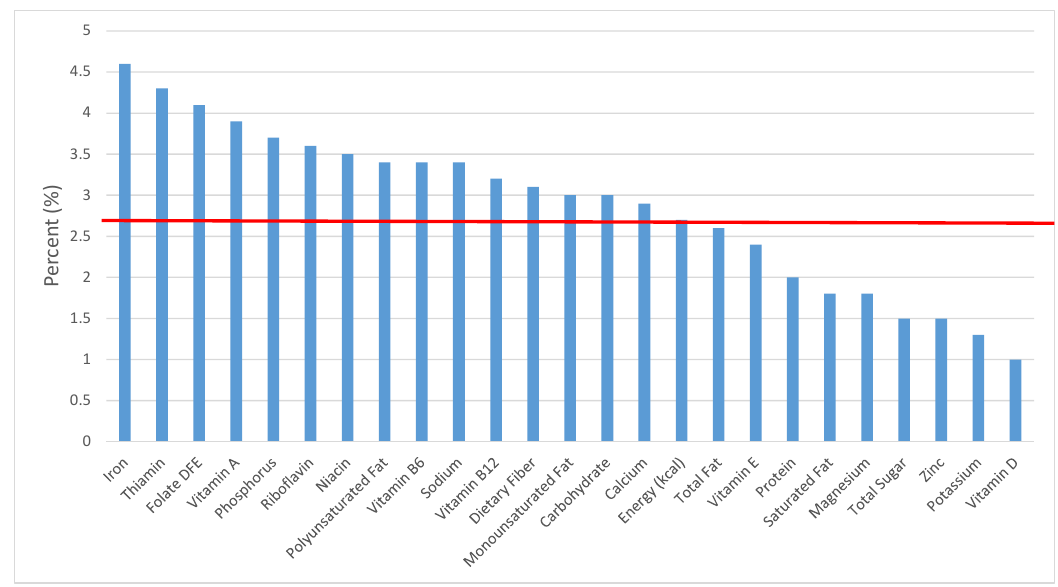
Figure 23. Quick breads and bread products as sources of energy and nutrients for children 4–8 years old ( N = 1917, daily intake data): DFE = Dietary Folate Equivalents; solid red line represents percentage of energy (kcal) provided in the diet relative to nutrients—nutrients above the red line show the grain food’s contribution to nutrient density.